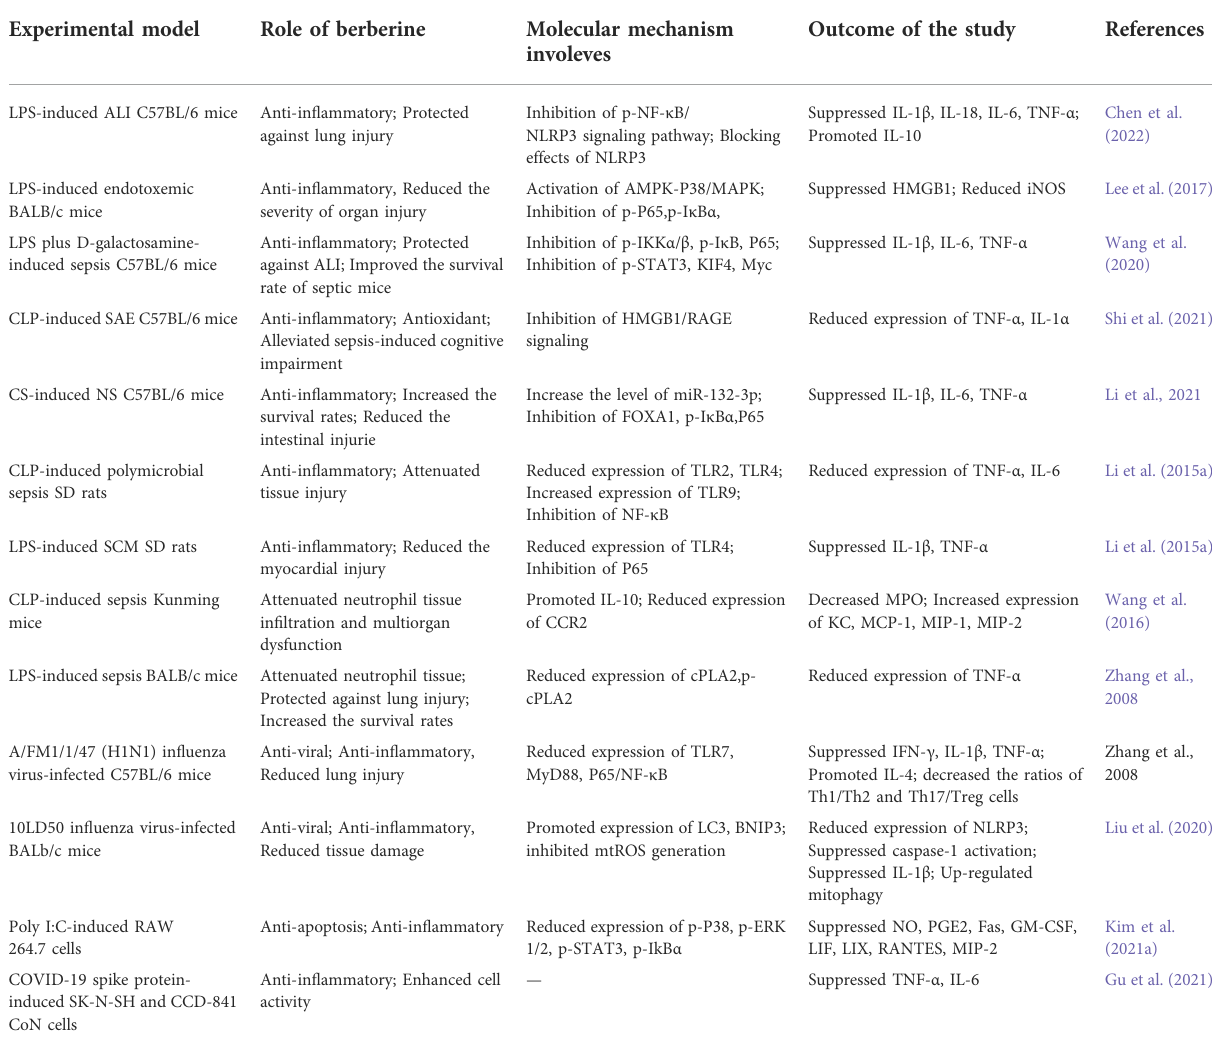
TABLE 3 The ameliorative effect of berberine on sepsis and viral